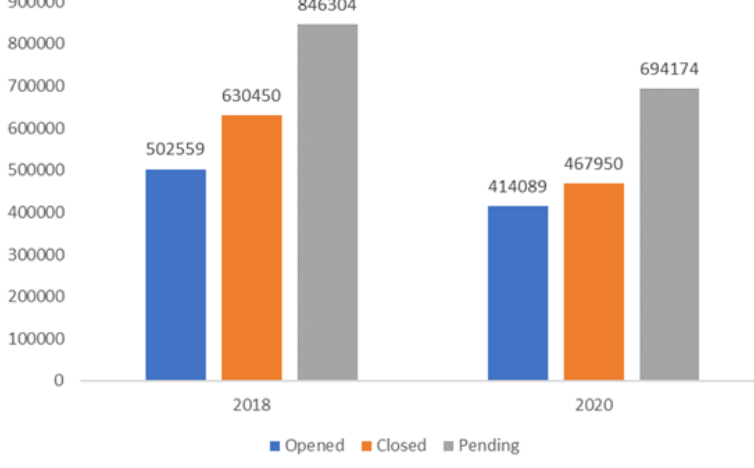
Figure 8: Case Flow at the Judicial District Courts